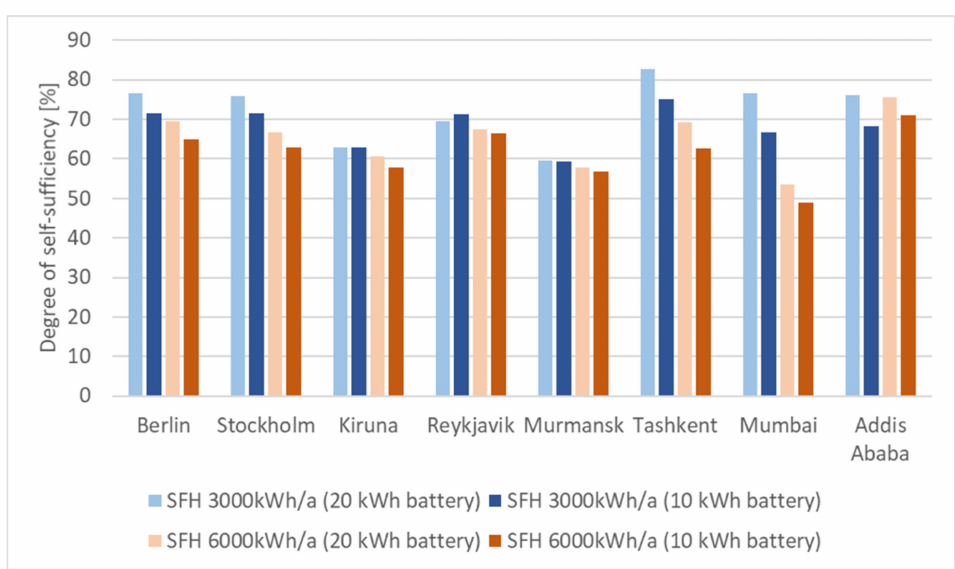
Figure 19. Comparison of the degree of self-sufficiency for different power consumption and battery storage sizes for several locations (single-family